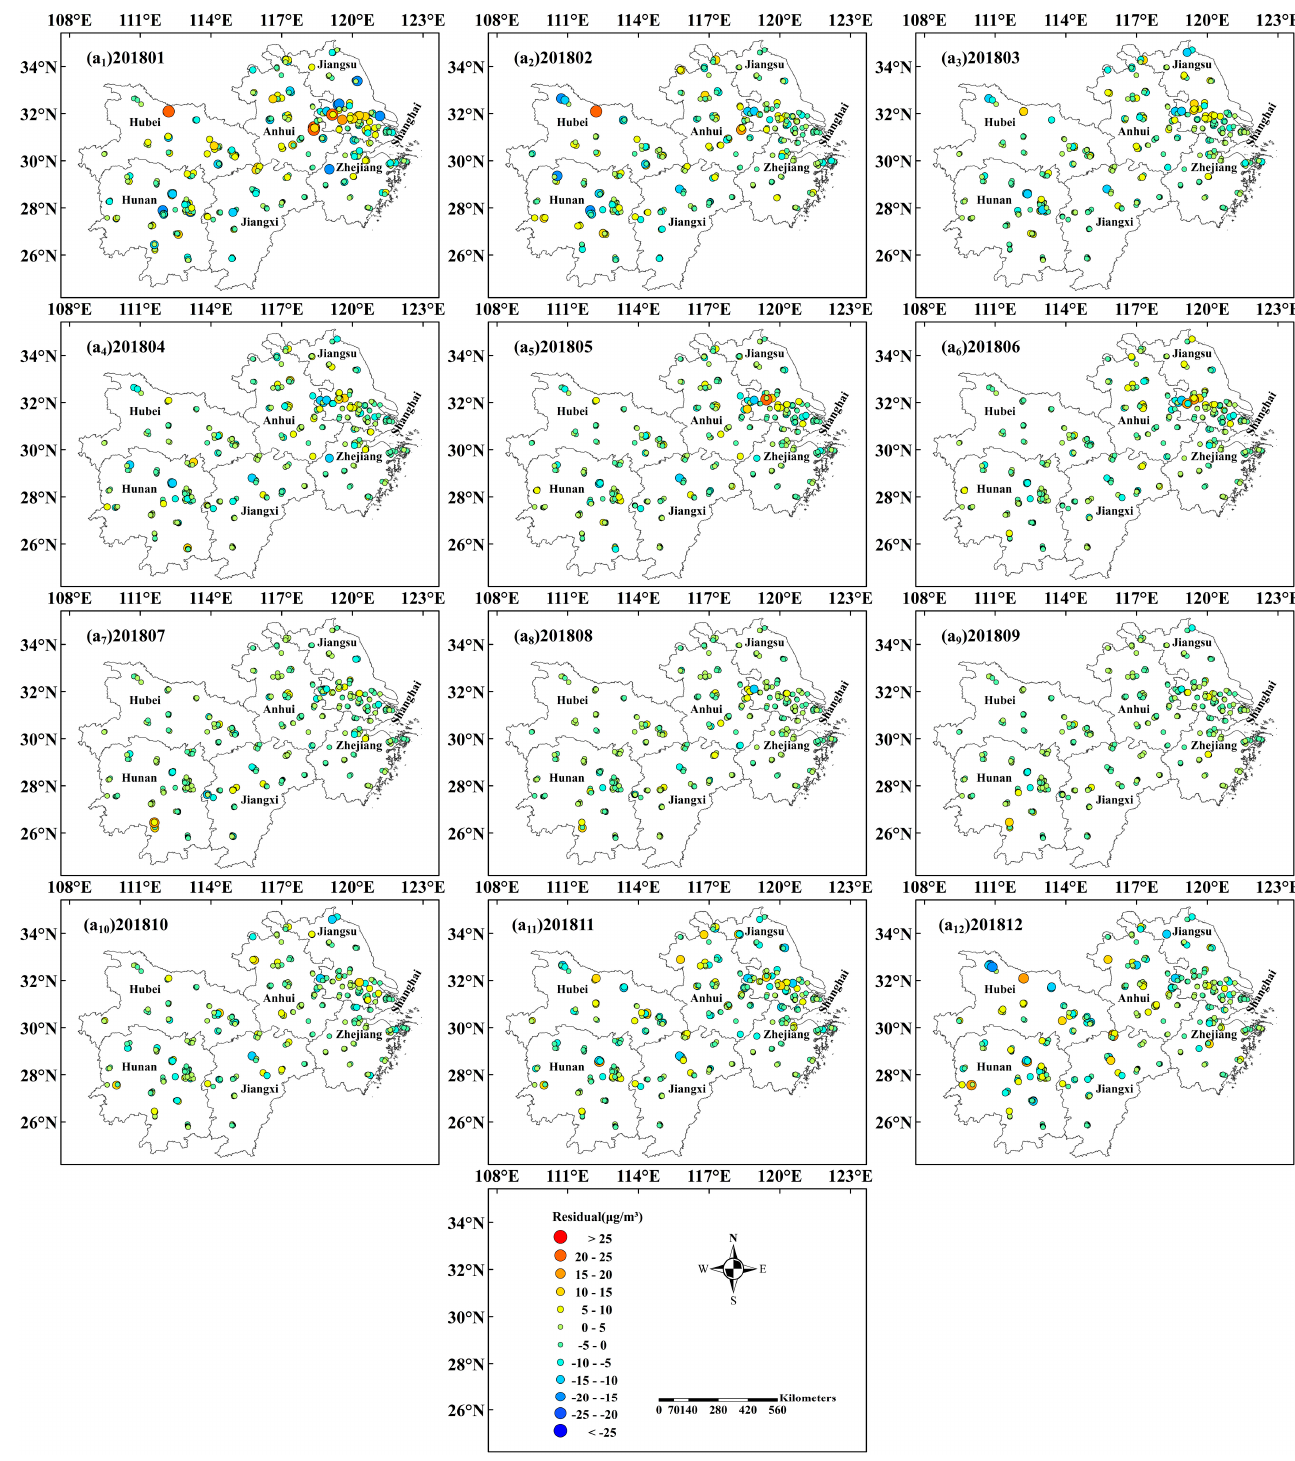
Figure 8. Merged plot of the spatial distribution of residuals of the PCA-GWR model for January– December 2018 ( a 1 – a 12 ).